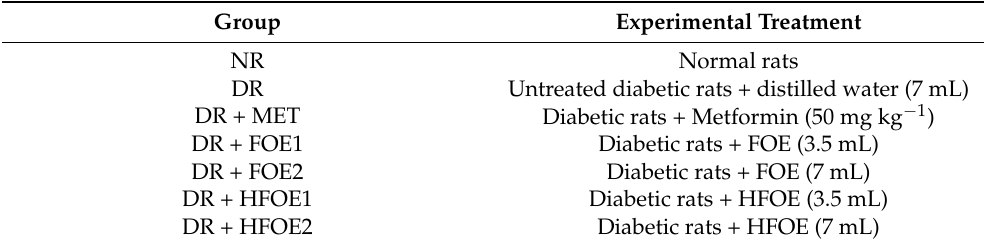
DR + HFOE1 Diabetic rats + HFOE (3.5 mL) DR + HFOE2 Diabetic rats + HFOE (7